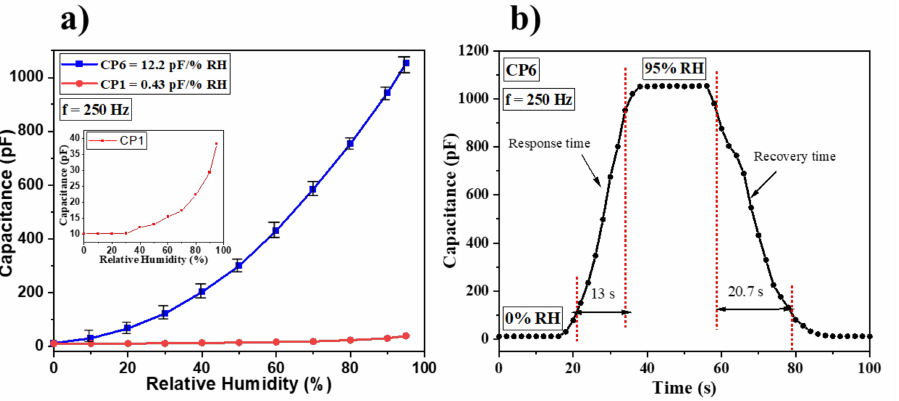
Figure 4. ( a ) Capacitance of CP6 - and CP1 -based sensors as a function of RH. Inset: Capacitance of CP1 as a function of RH and ( b ) response and recovery curves for CP6 sensor at 250